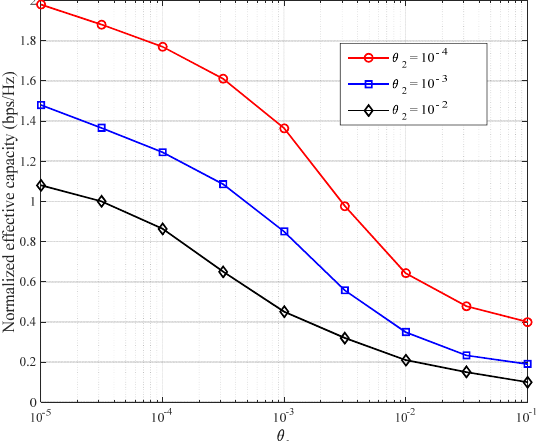
Figure 10. Relationship between effective network capacity and QoS index for simultaneous multiple services.